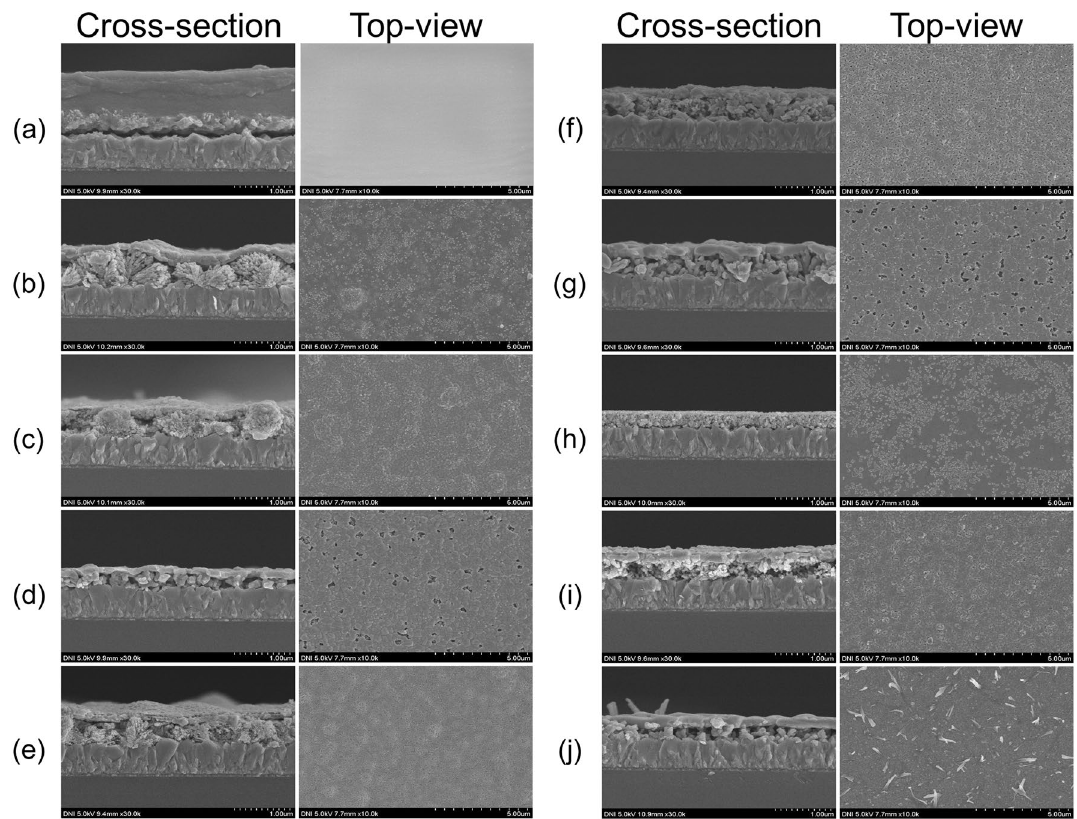
Figure 2. Cross-section and Planar view of the FTO/CuO/CuBi 2 O 4 electrodes. Note: ( a ) S05000; ( b ) S05350; ( c ) S05450; ( d ) S05550; ( e ) S10350; ( f ) S10450; ( g ) S10550; ( h ) S15350; ( i ) S15450; ( j )